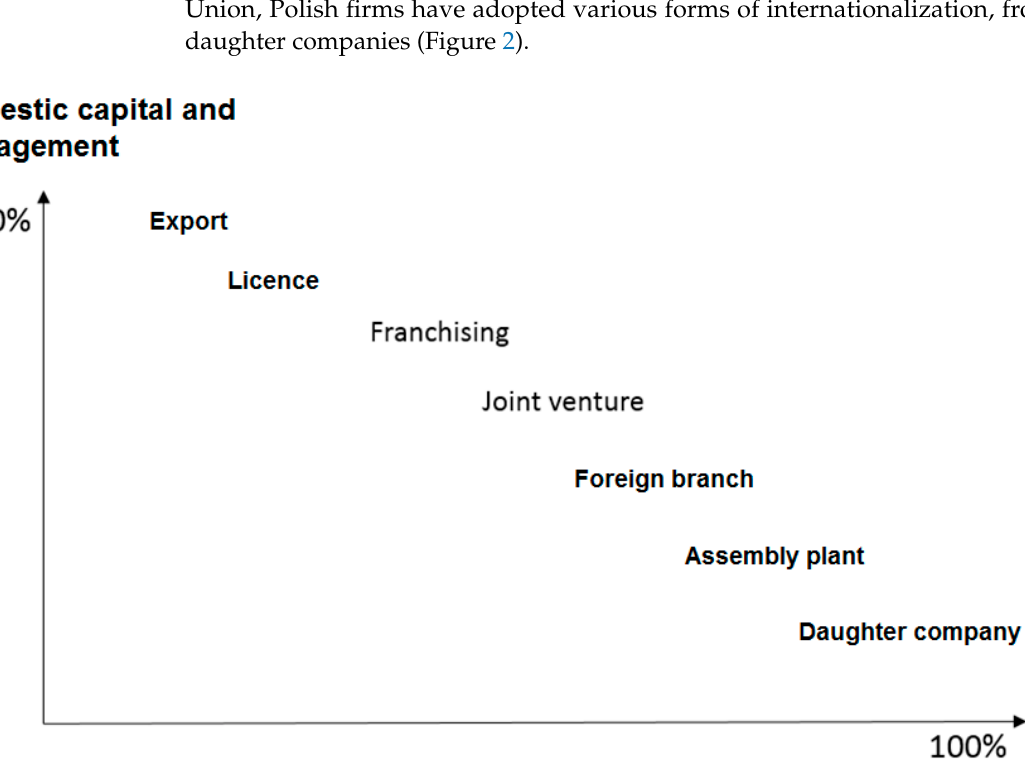
Figure 2. Internationalization of Polish firms.